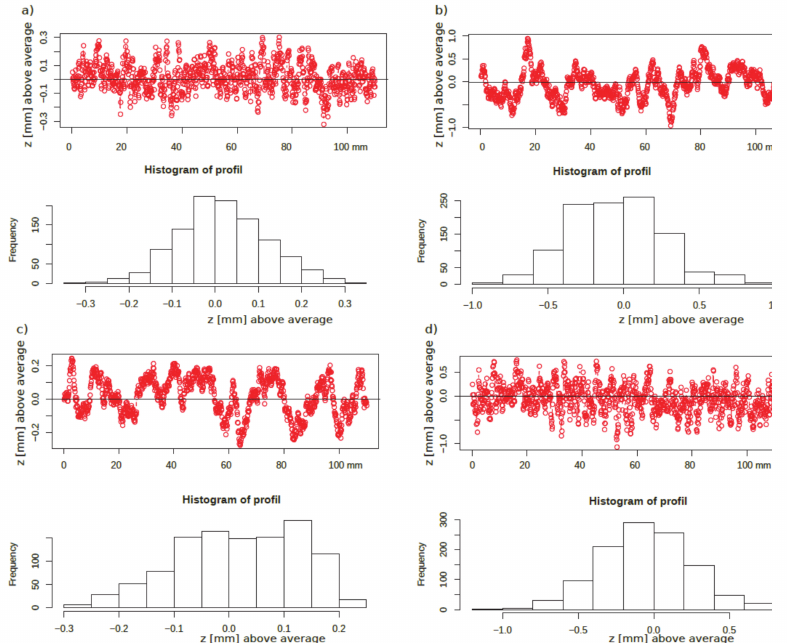
Figure 12. Examples of virtual profiles based on the spherical model with parameters: ( a ) s = 0.01 mm 2 , r = 1 mm, ( b ) s = 0.1 mm 2 , r = 5 mm, ( c ) s = 0.01 mm 2 , r = 5 mm, ( d ) s = 0.1 mm 2 , r = 1 mm. All profiles are supplied with histograms of z . (Horizontal axis - index is a vector of distance in 100 µ